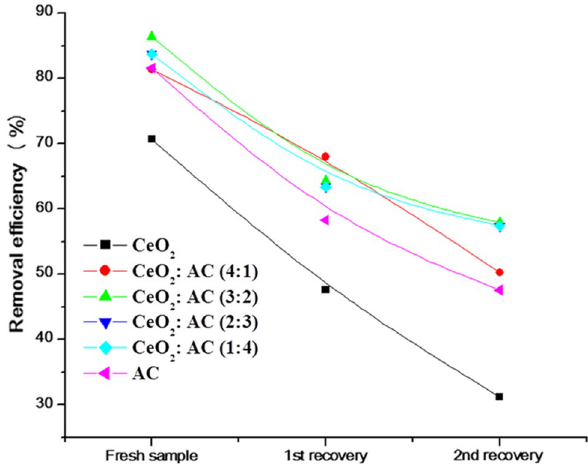
Fig. 12 Reusability and regeneration efficiency of CeO ites for photocatalytic degradation